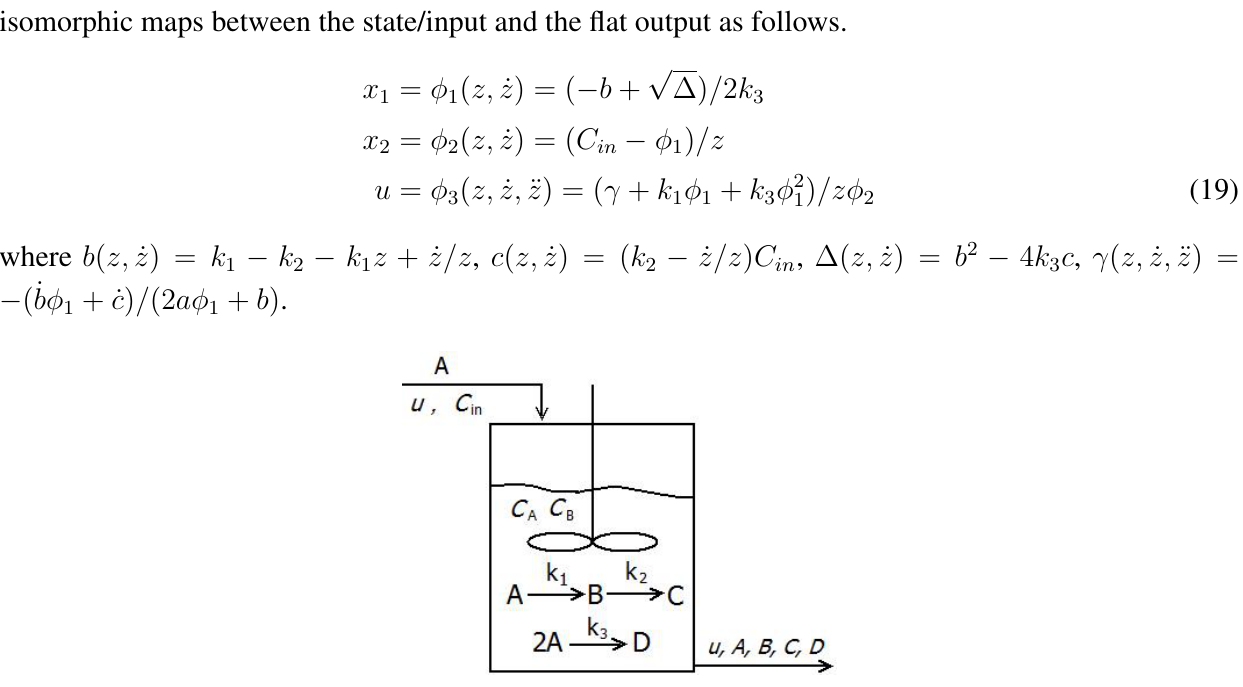
Figure 3. CSTRin the case study.